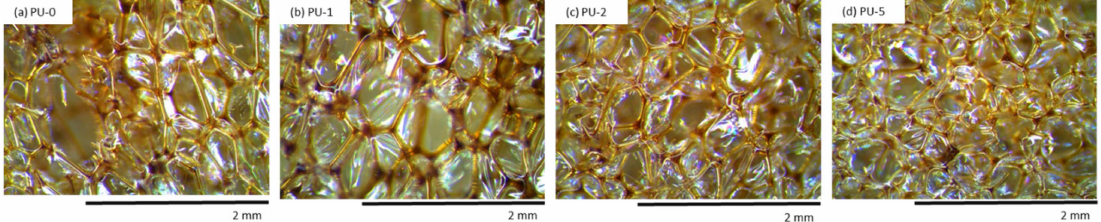
Figure 14. Morphology of ( a ) PU-0, ( b ) PU-1, ( c ) PU-2, ( d ) PU-5 after 7 days of UV aging observed at a magnification of 50 ×